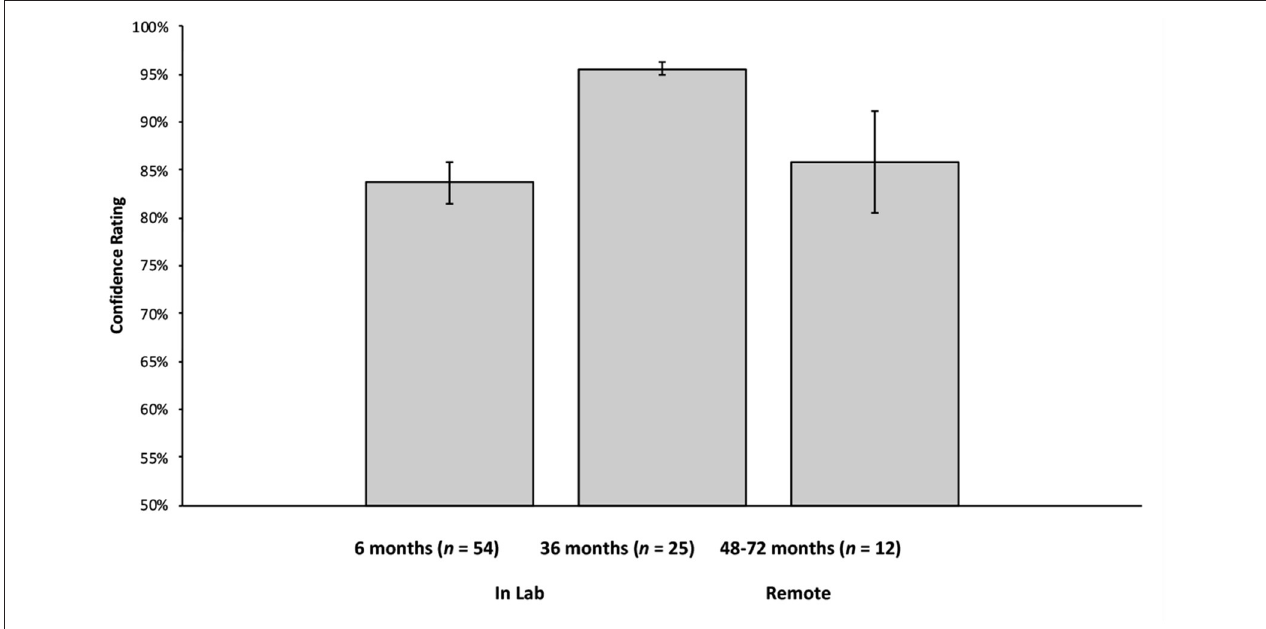
FIGURE 2 | Mean confidence ratings for 6-month-old infants (tested in the lab), 36-month-old children (tested in the lab), and 48–72-month-old children (tested remotely). Error bars reflect standard errors of the means. OpenFace provides a confidence rating for every frame of a video (using all face, head position, and gaze direction landmarks). The confidence rating is a measure of how well OpenFace can identify all of these components (averaged across all frames for each